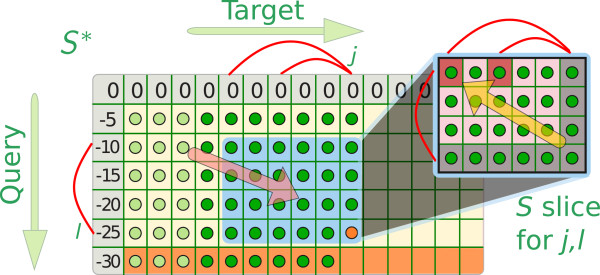
Schematic view of the computation of S∗ by LocARNAscan. The dark green dots in
Sj,l∗ are sufficient to calculate the current entry
Sj,l∗, given the set of arcs indicated by red lines.